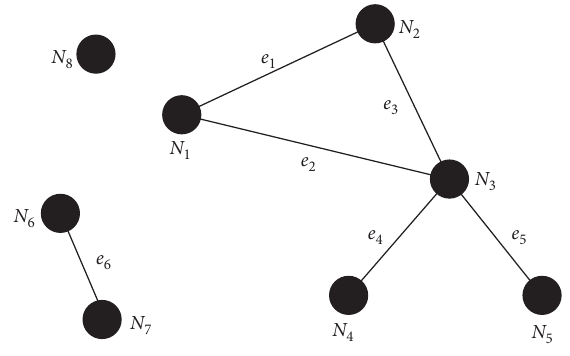
Figure 1: Information flow between